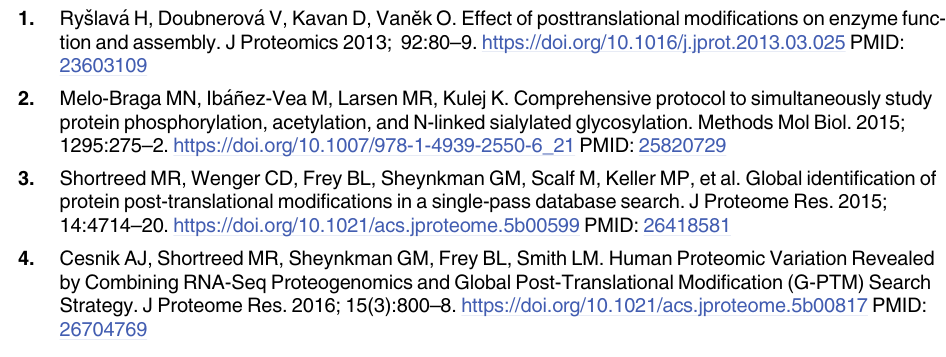
S10 Table. Phosphorylated peptides of FDA-approved biomarkers in control and GBM plasma samples. S11 Table. Nt-acetylated peptides of FDA-approved biomarkers in control and GBM plasma